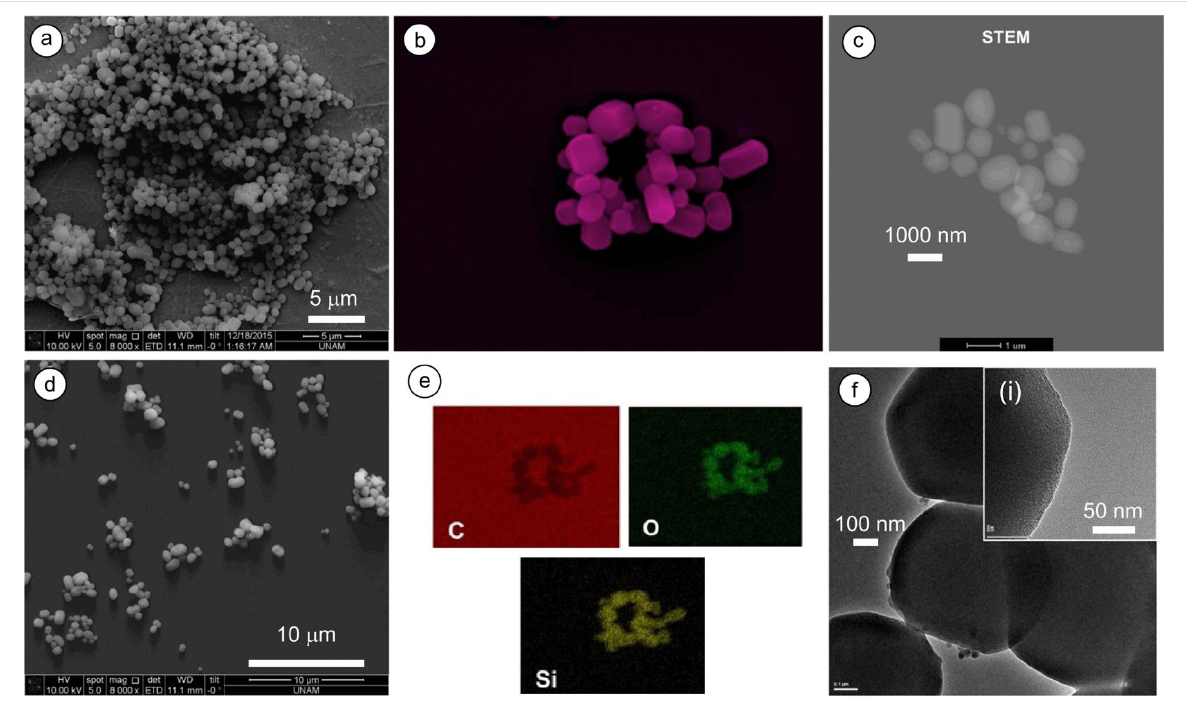
Figure 3: Electron microscopy images of MSNs (MSN-3) produced at 0.25% (w/v) of HP- γ -CD. (a, d) SEM photos, (b, c) STEM images, (e) EDX mappings for C, O and Si elements, and (f) TEM image of MSNs. (i) Inset shows a HRTEM image of the particle. c CD = 0.25% (w/v) and r (CD/CTAC) =